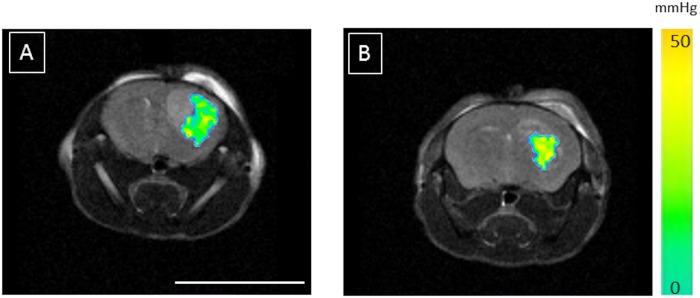
Tumor pO2 assessed using perfluorocarbon loaded lipid nanocapsules.The average pO2 value of the tumor arising from the cells cultured under mild hypoxia (3% O2) (A) is measured at 47 ± 3 mmHg (ca. 6.2% O2) whereas a value of 33 ± 3 mmHg is measured (ca. 4.3% O2) in the tumor arising from cells cultured under normoxia (21% O2) (B) (p <0.01). Those values were measured under isoflurane anesthesia and spontaneous air breathing. Scale bar = 1cm.